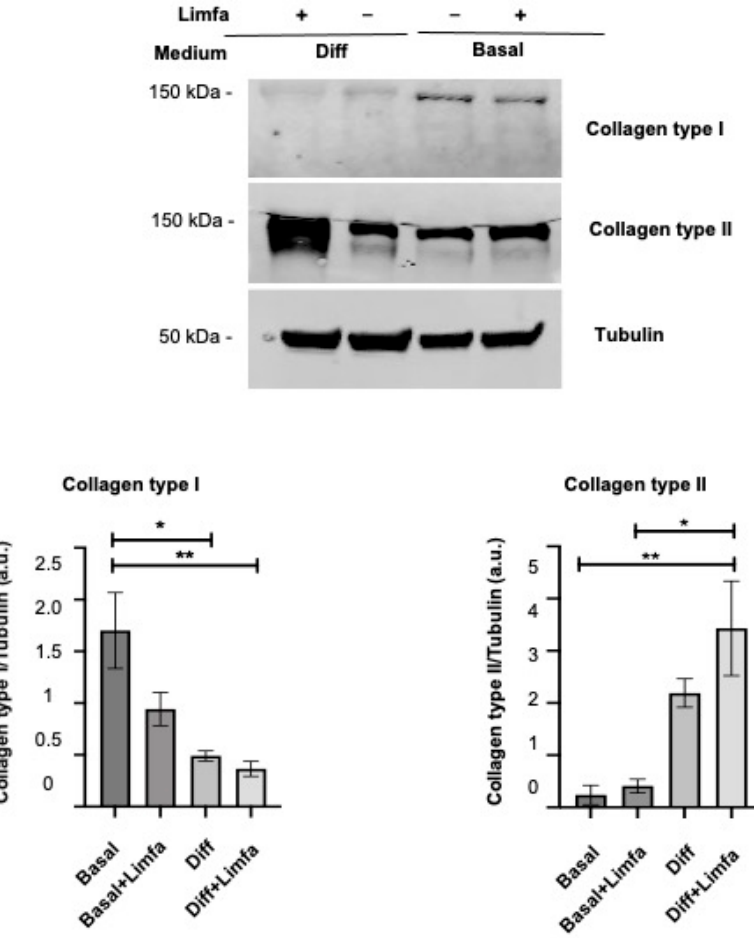
Figure 3. Western Blot analysis of Collagen I and Collagen II expression in different cultures and treatment conditions. Results are expressed as arbitrary units (a.u.) and normalized on Tubulin input. Basal—Basal medium; Diff—differentiation medium; Limfa—Limfa ® Therapy treatment. Ex- periments are means of three different repeats. Error standard is reported. * = p < 0.05; ** = p < 0.025 (One-Way ANOVA).